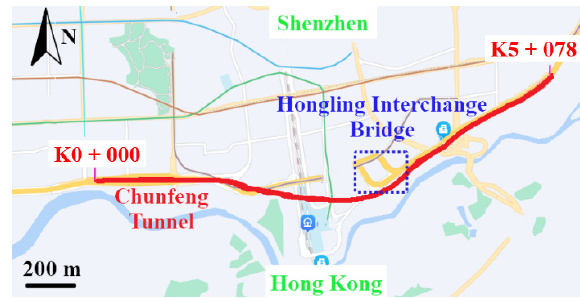
Figure 1. Plan of the line.